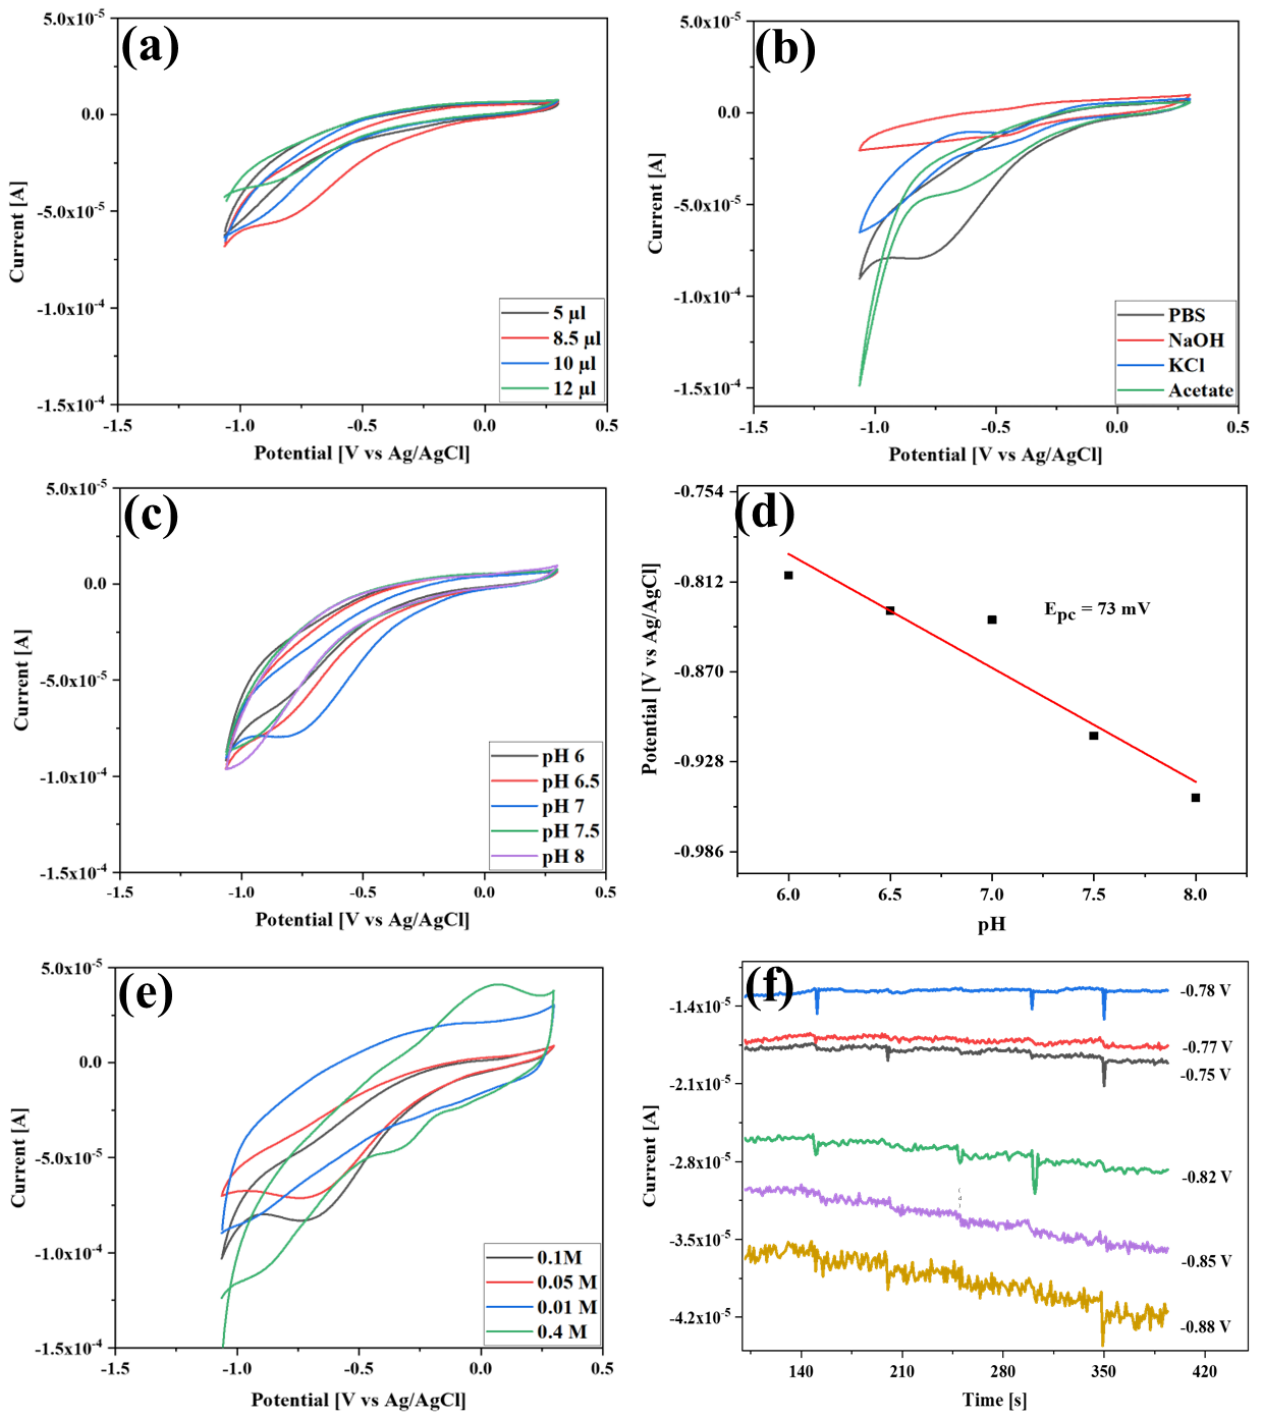
Figure 5. CV-based identification of ( a ) a suitable Au NPs amount with 3 mM of H 2 O 2; ( b ) a suitable electrolyte media; ( c ) a suitable pH; ( d ) the corresponding reduction peak vs. pH curve; ( e ) a suitable PBS (pH 7) concentration in the presence of 5 mM of H 2 O 2 at a 17 mV/s at scan rate; ( f ) a suitable amperometric reduction potential by adding 50 µM of H 2 O 2 in 0.1 M PBS (pH 7.0). Determining the appropriate reduction potential is paramount to obtaining a supe- rior sensing performance with less noise. Figure 5f demonstrates the multiple-step chron- oamperometry study of the GCE/Au NPs/SnO 2 NFs composite electrode performed in 0.1 M PBS by adding 50 µM of H 2 O 2 in potentials ranging from − 0.75 V to − 88 V. As the